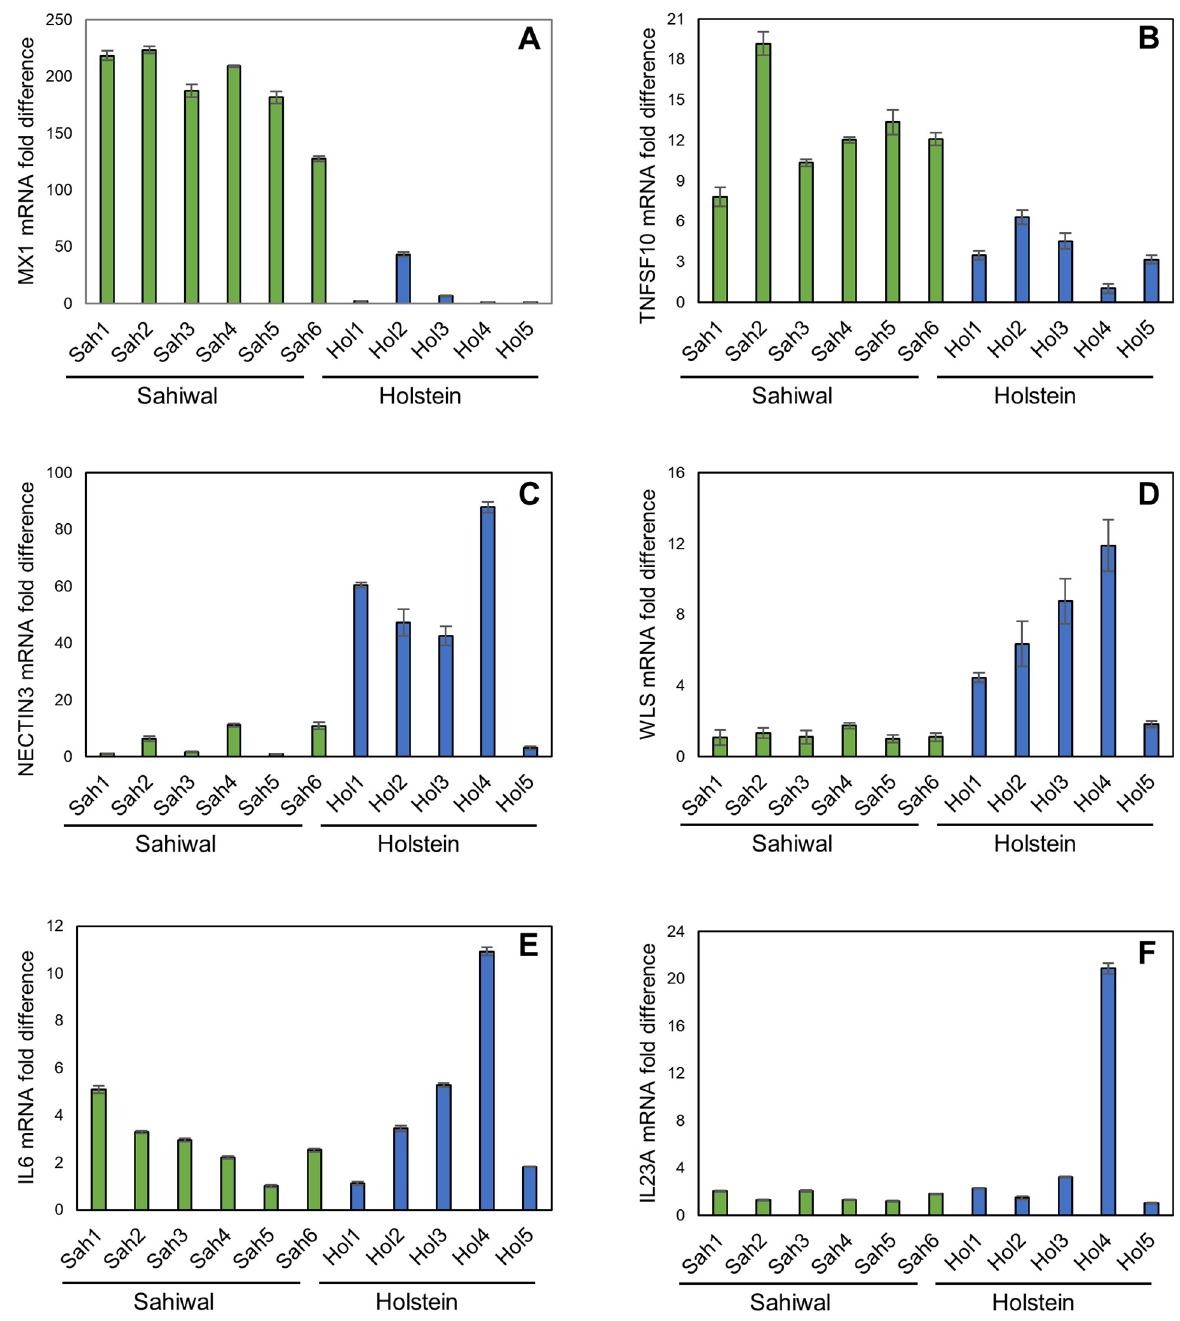
Fig 5. qRT-PCR validation of candidate H/S-DE genes. Panels show results for representative genes. (A) MX1 ; (B) TNSF10 ; (C) NECTIN3 ; (D) WLS ; (E) IL6 ; (F) IL23A . Within each panel Y axis shows mRNA fold difference (calculated vs . the lowest expressed sample); X axis designates sample number and breed; Hol1-5, Holstein; Sah1-6, Sahiwal. https://doi.org/10.1371/journal.pone.0262051.g005 for Holstein infected cells relative to Sahiwal, variability within the data precluded validation of a significant difference (Table 4, Fig 5E & 5F). IPA analysis of our RNA-seq datasets predicted marked differences between Holstein and Sahiwal infected cells in pathways linked to activation of and response to type I IFN. However,